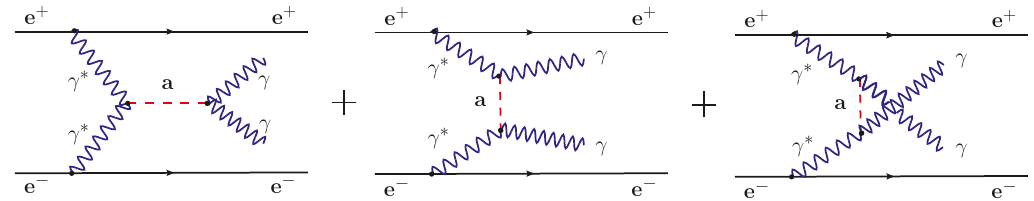
Figure 8 . The Feynman diagrams describing photon-induced light-by-light virtual production of the axion-like particle a in e + e −